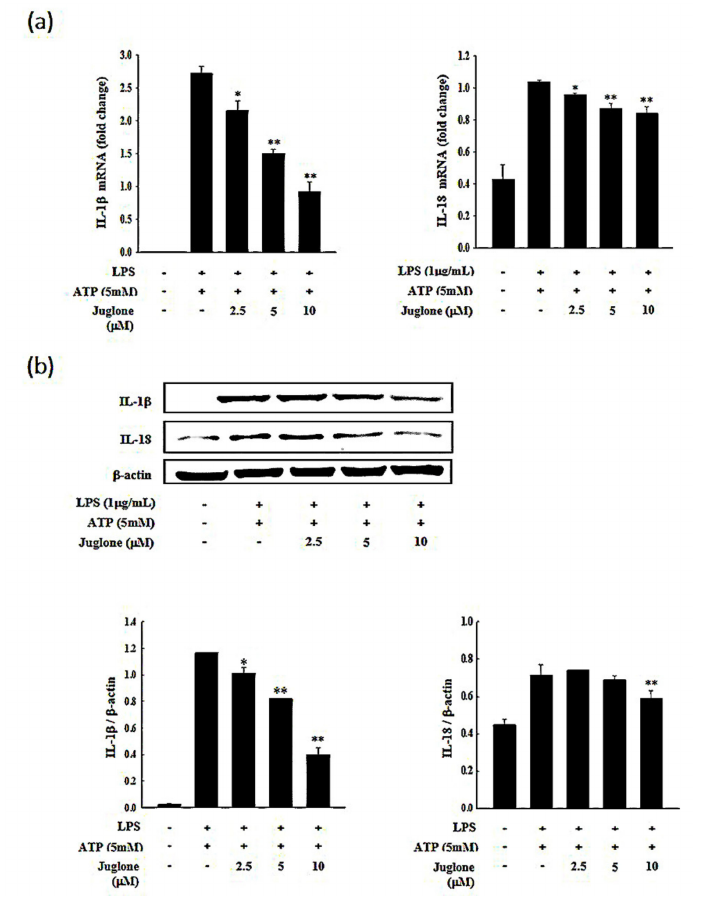
Figure 3. E ff ects of juglone on IL-1 β and IL-18 expression in LPS-treated J774.1 cells. J774.1 macrophages were treated with di ff erent concentrations of juglone (2.5, 5, and 10 µ M) for 2 h, followed by treatment with 1 µ g / mL LPS for 6 h and 5 mM ATP for 1 h. ( a ) The mRNA levels of IL-1 β and IL-18 in J774.1 cells were determined with RT-qPCR. Glyceraldehyde 3-phosphate dehydrogenase gene (GAPDH) was used as a reference gene. ( b ) The protein levels of IL-1 β and IL-18 in J774.1 cells were assessed by Western blotting and are presented as relative to β -actin intensity. Data are presented as mean ± SD. * p < 0.05; ** p < 0.01 vs. LPS + ATP treated